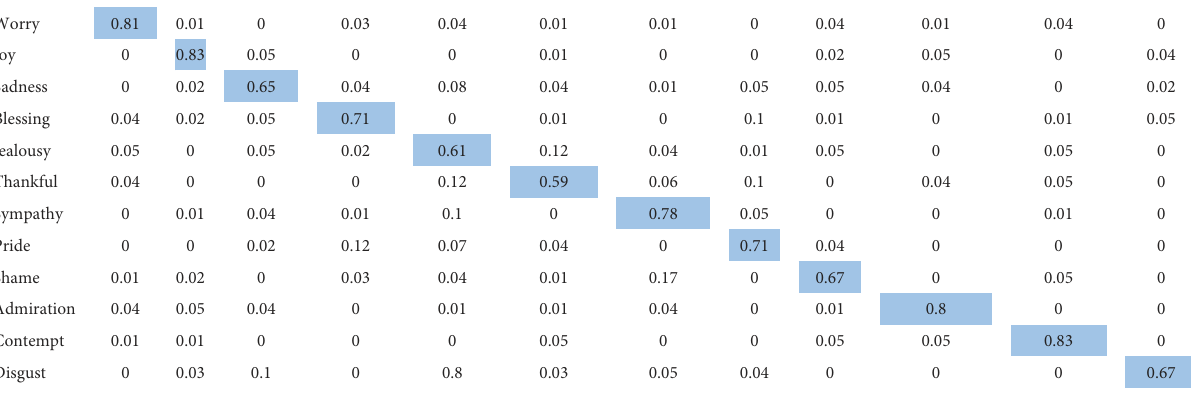
TABLE 6 12-Class sentiment classification confusion matrix (Flat-OCC).